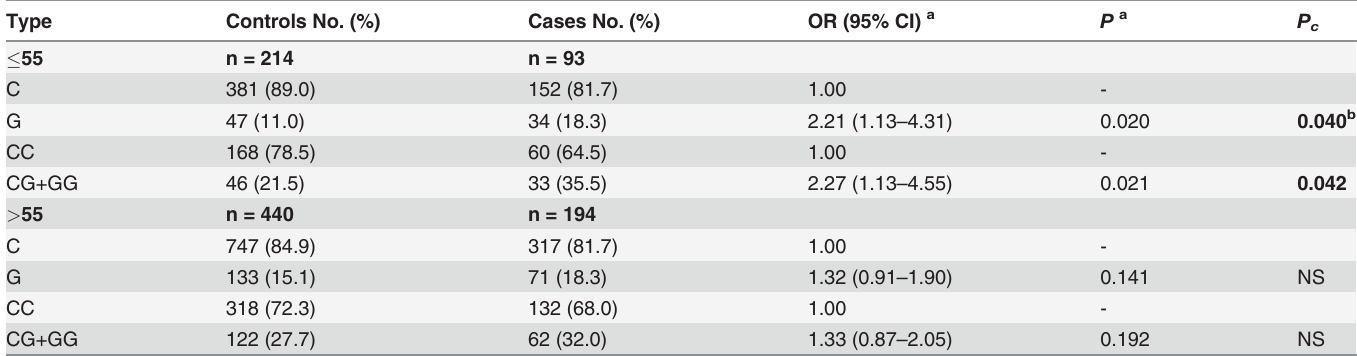
Table 3. Multivariate associations of the rs7069102 in SIRT1 gene with the risk of MI by further strati fi cation for age. Type Controls No.